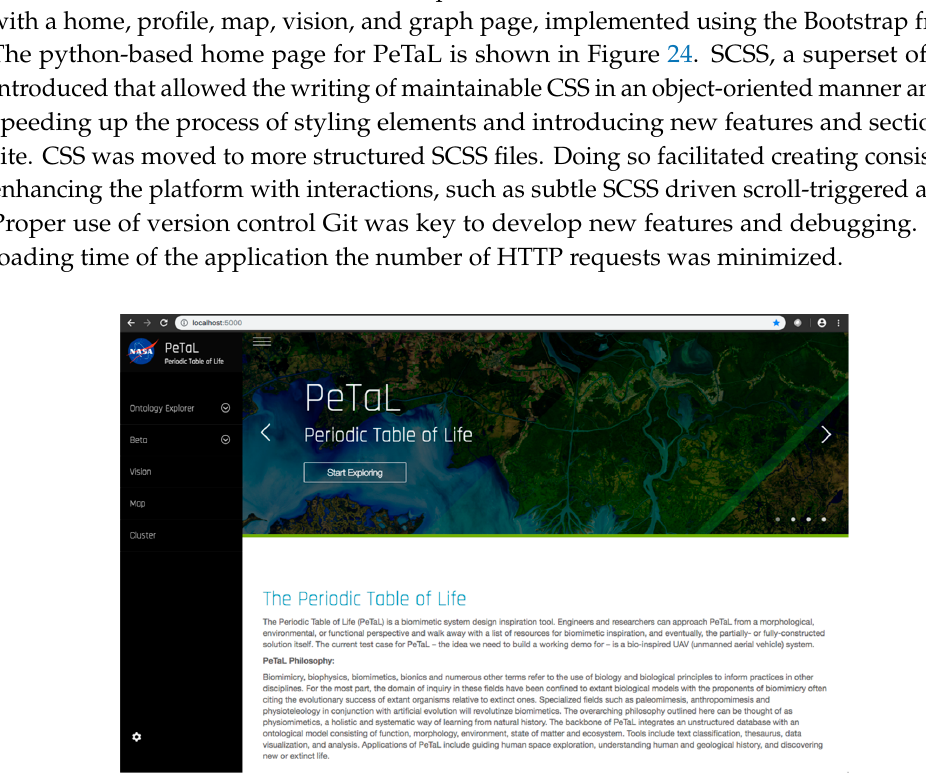
Figure 24. Home page of the Periodic Table of Life (PeTaL).